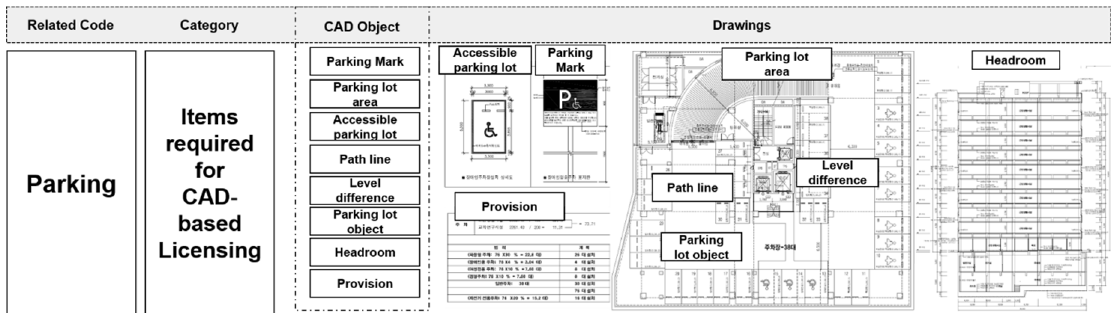
Figure 7. Drawing requirements and example drawings in the building information modeling (BIM) format.